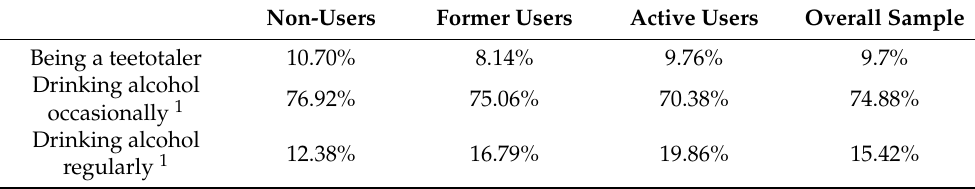
Table 2. Percentage of participants who declared using alcohol occasionally or